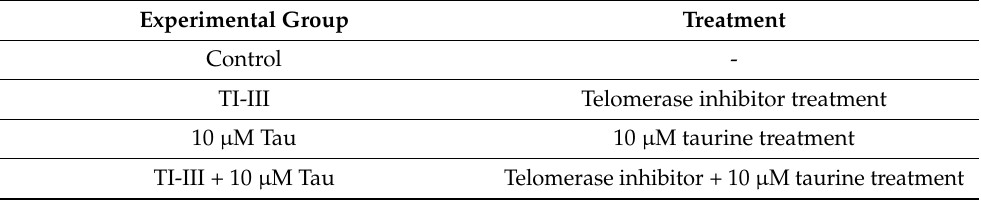
Table 2. Effect of taurine on TERT gene and protein expression—Experimental